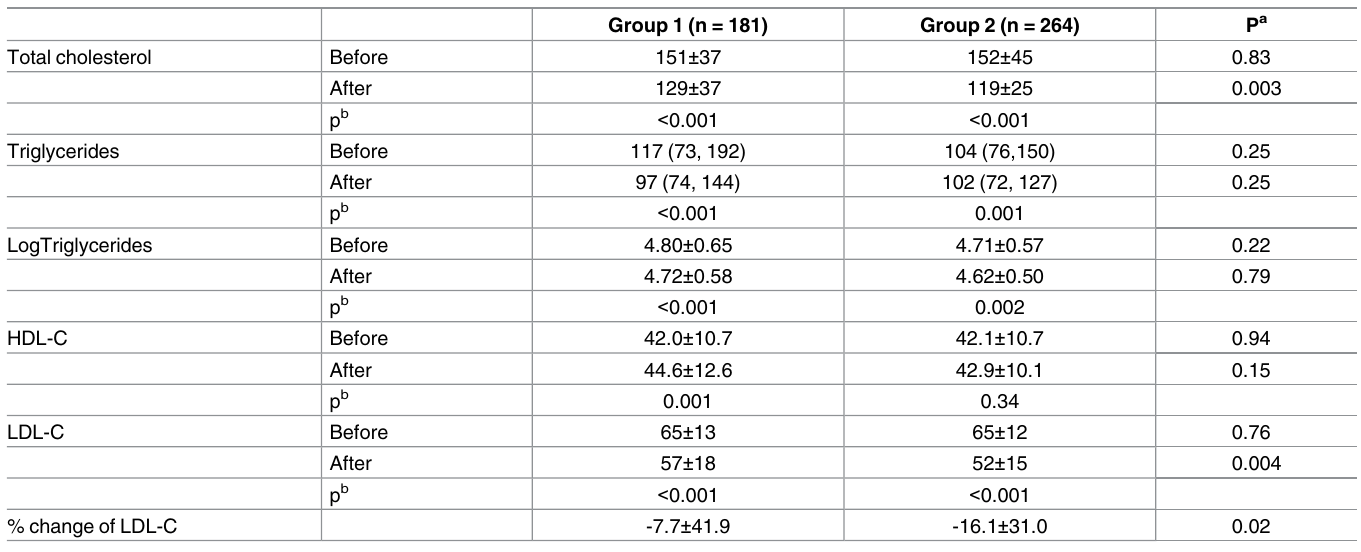
Table 2. Changes in lipid profiles.